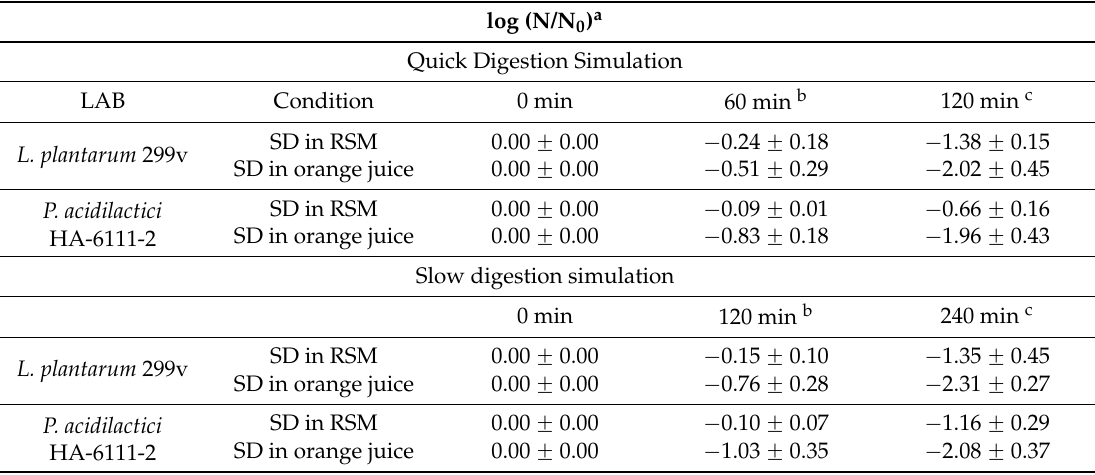
Table 2. Survival of LAB isolates after 12 months of storage after spray-drying (SD) in RSM or in orange juice with 10 DE maltodextrin, through quick and slow digestions